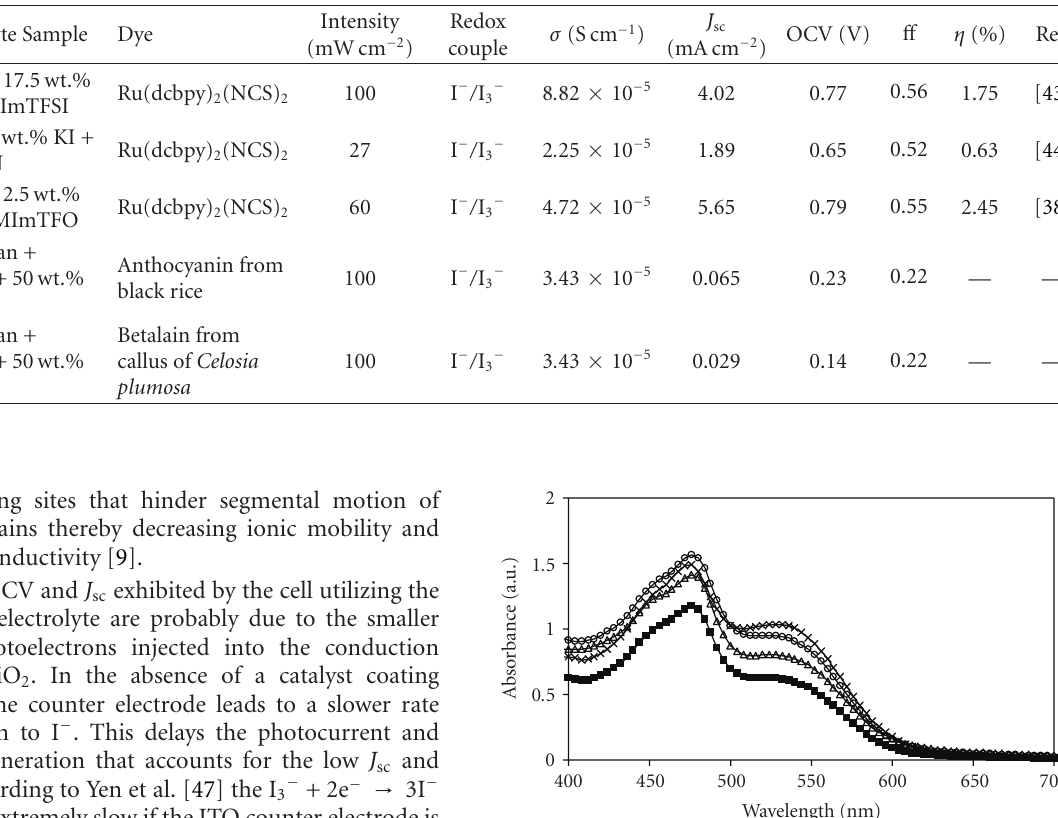
Table 4: Characteristics of PEC cells using polymer-salt-ionic liquid systems.